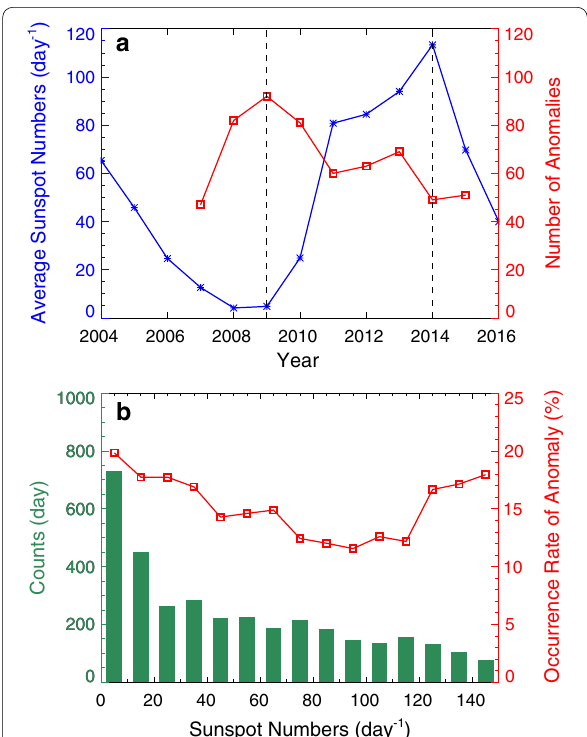
Fig. 4 Statistical analysis on the FS3 anomalies in combination with sunspot numbers. a Relationship between solar cycle variations and the number of the FS3 anomalies. The two dash lines denote solar minimum and solar maximum. The blue asterisks denote the yearly averages of daily sunspot numbers for individual years. The red squares indicate the numbers of the FS3 anomalies for individual years. b Relationship between the occurrence rate of the FS3 anomalies and sunspot numbers. The green histogram illustrates the days in terms of sunspot numbers during the mission period of FS3. The red squares represent the occurrence rates of the FS3